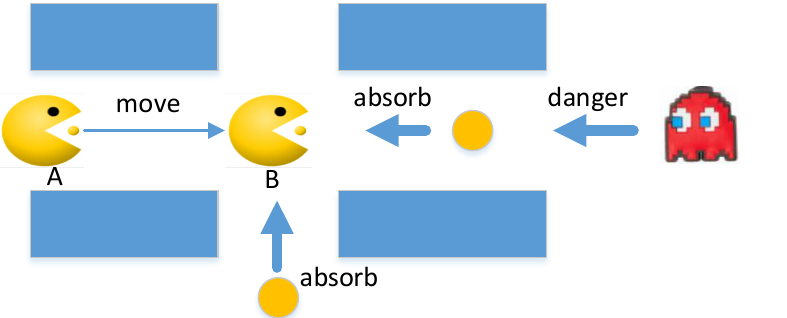
Figure 4. The role of influence maps in decision making.